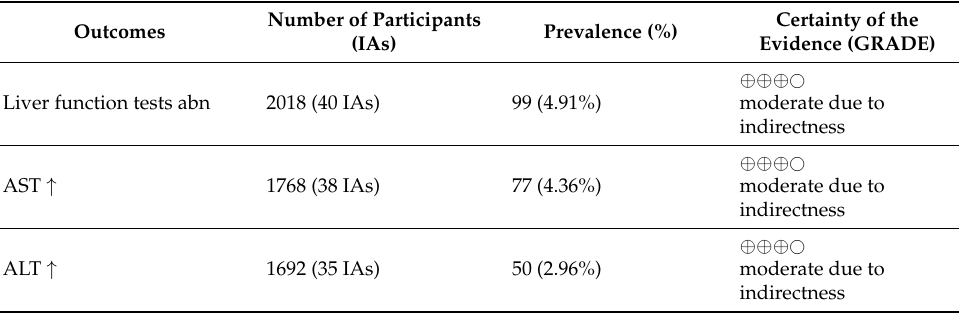
Table 12. Summary of ISO therapy adverse events: laboratory